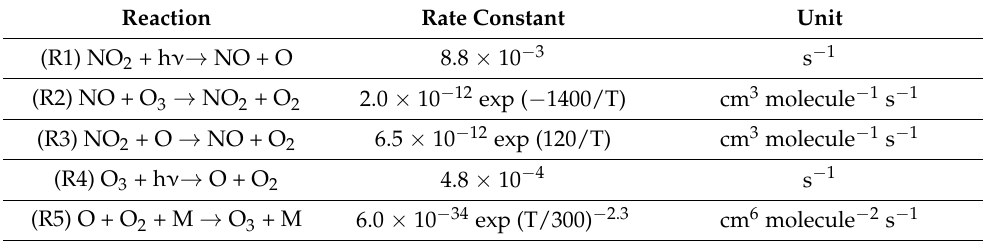
Table 1. NOx- O 3 chemical reactions and their rate